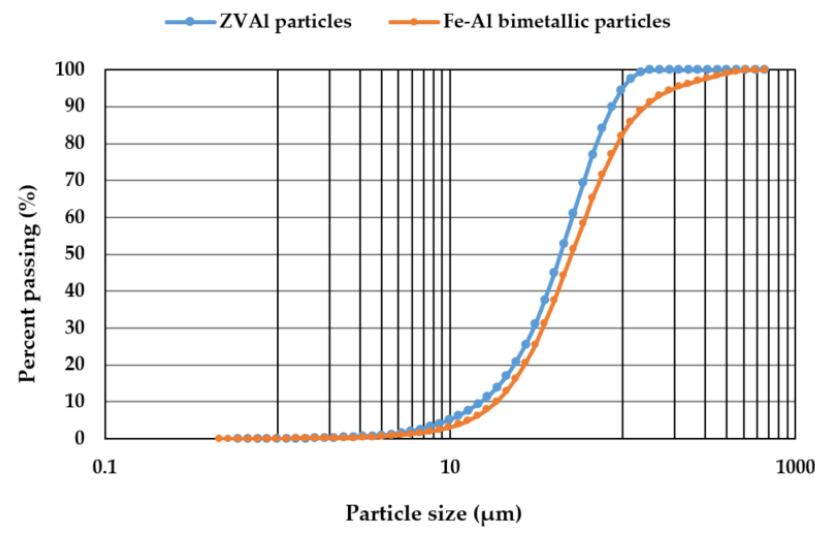
Figure 1. Cumulative particle size distribution of ZVAl and Fe-Al bimetallic material.